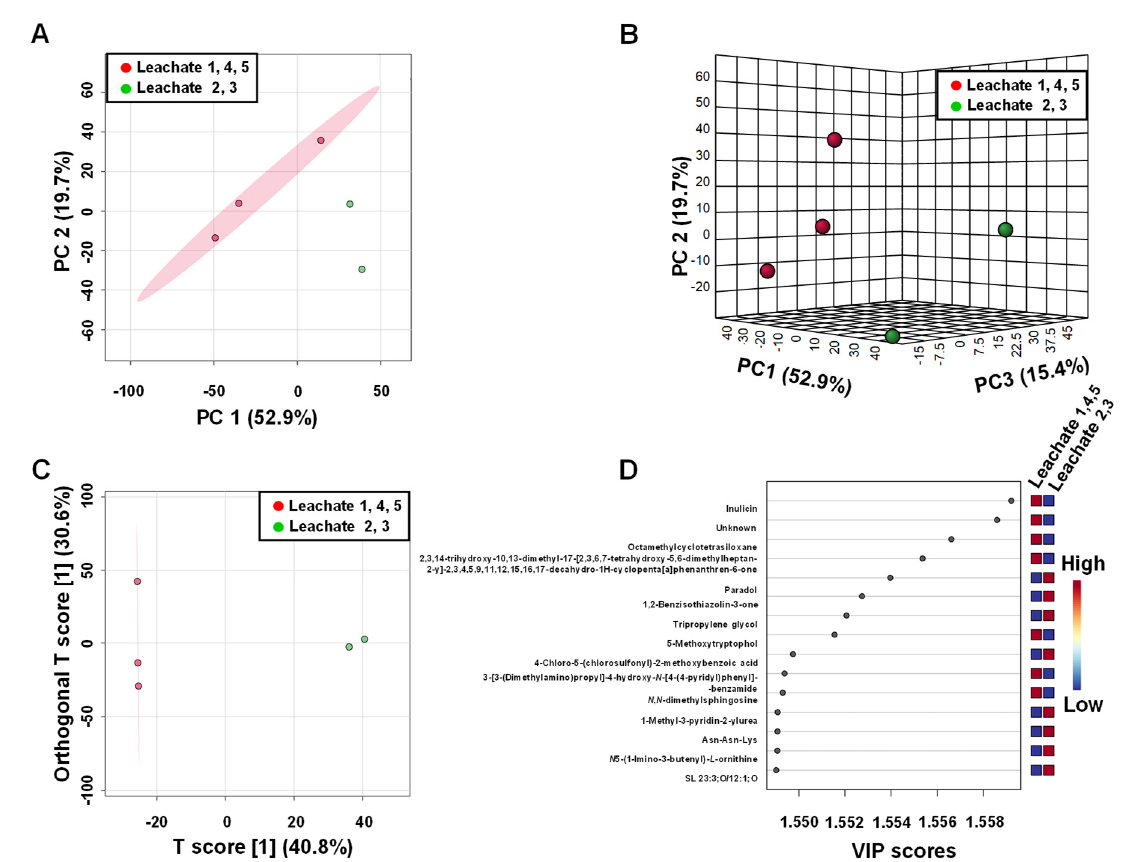
Figure 12. Analysis of leachate compound profiles created for LC-MS data. ( A ) 2D PCA; ( B ) 3D PCA; ( C ) OPLS-DA scores plots generated from the LC MS data of leachates 2, 4 and 5 (red) and leachates 2 and 3 (green); ( D ) Metabolite ranking for the OPLS-DA model according to VIP scores.